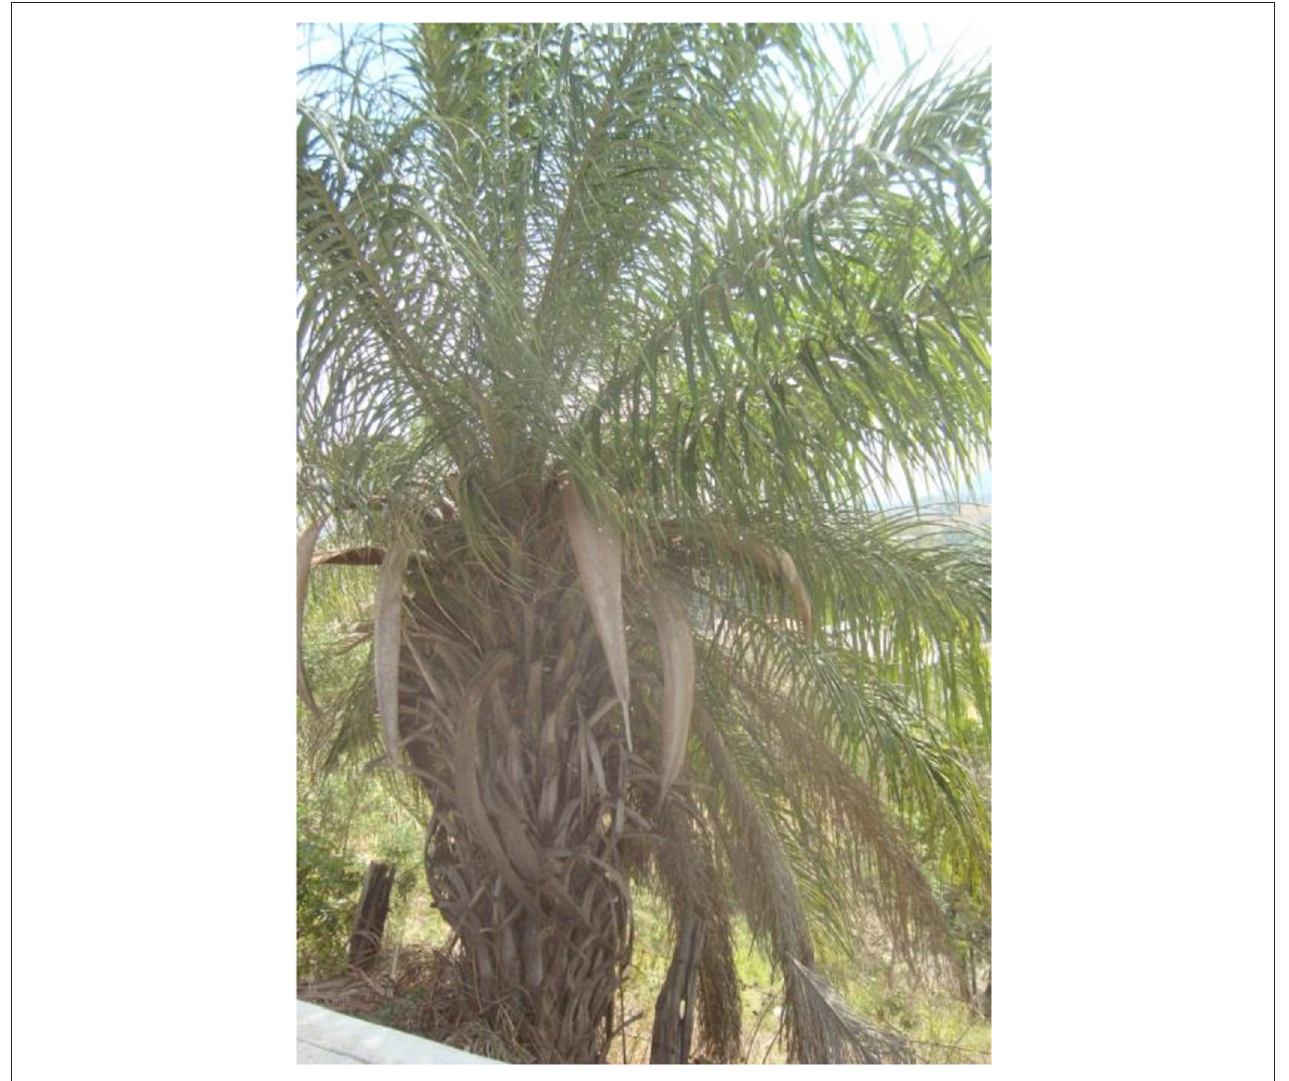
FIGURE 1 | Acrocomia aculeata in field, ready for cutting for taberna